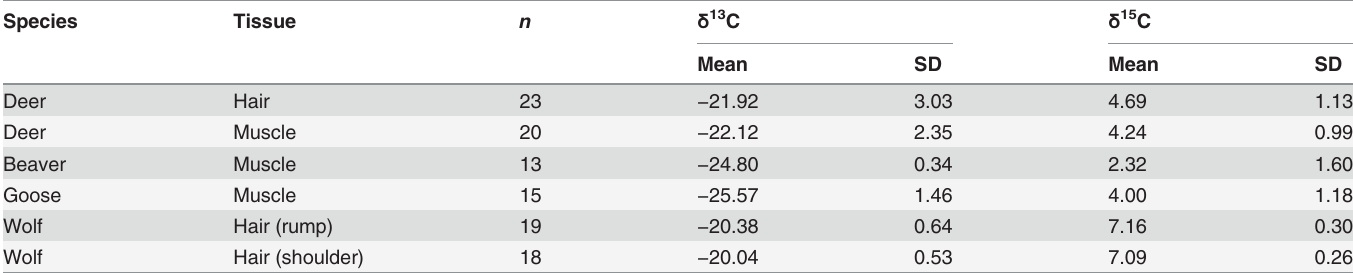
Table 1. Mean and SD of δ 13 C and δ 15 N for tissue samples collected from a subsample of white-tailed deer, beaver, and goose fed to gray wolves ( n = 10) during a captive feeding study of wolves in Forest Lake, Minnesota, USA, 2011 – 2012. Species